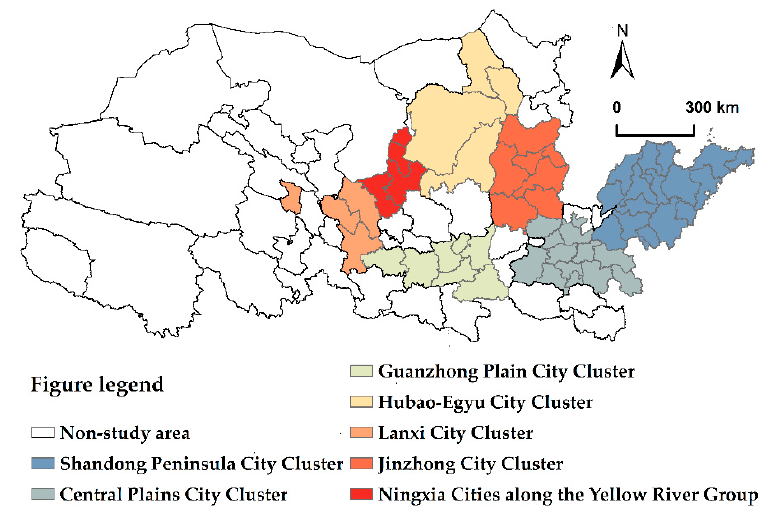
Figure 1. Study Figure 1. Study area.